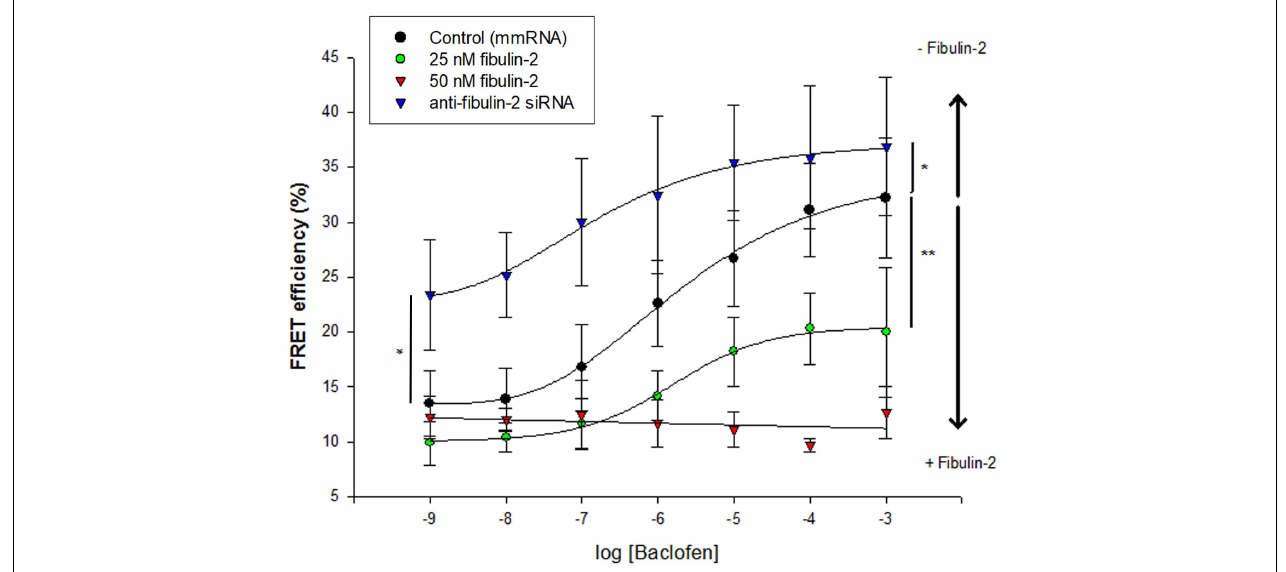
FIGURE 1 | Fibulin-2 regulates baclofen-induced GABAB conformational changes in vitro. Fibulin-2 dose-dependently prevents agonist-induced conformational changes. FRET efficiency is measured between GFP-GABAB1a and DsRed-GABAB2 with different concentrations of baclofen (1 nM to 1 mM) (black circles, control). When fibulin-2 expression is inhibited with anti-fibulin-2 siRNA (blue triangles), efficacy of baclofen is increased (maximal effect of blue plot vs. black plot, ∗ p < 0.05). In contrast, in cells treated with exogenous fibulin-2 protein at 25 nM (green plot), maximal effect of baclofen is decreased as compared to control (maximal effect of fibulin-2 at 25 nM vs. control, ∗∗ p < 0.01). With 50 nM of fibulin-2 (red plot), the FRET efficiency between the two subunits is abolished. 20 < n < 30. Two Way ANOVA, Tukey post hoc test: ∗ p < 0.05; ∗∗ p <